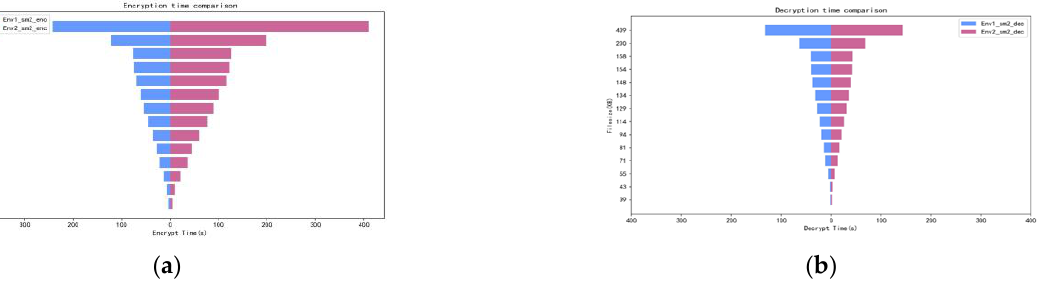
Figure 13. Time consumption of encryption ( a ) and decryption ( b ) of different experimental samples using SM2.